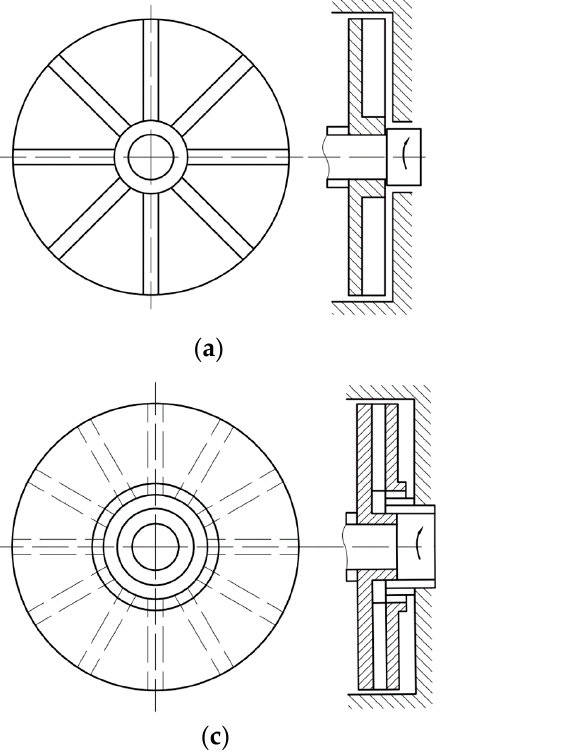
Figure 1. Common structures of the centrifugal sealing impellers: ( a ) open impeller with blades; ( b ) semi-open impeller with blades; ( c ) closed impeller with blades; and ( d ) open impeller with flow channel (groove).